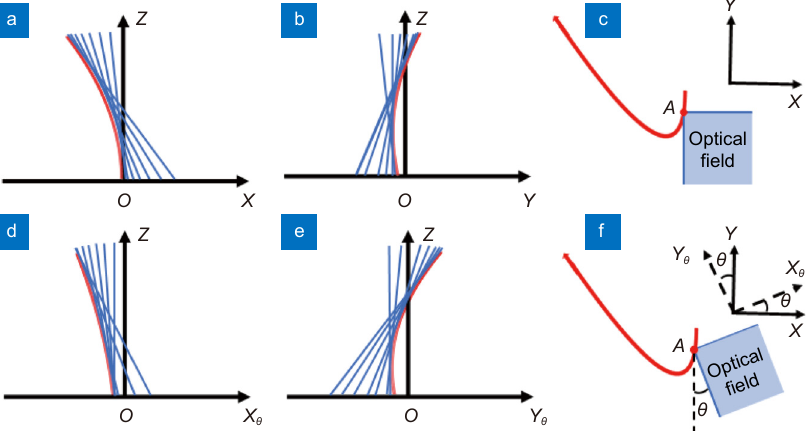
Fig. 1 | Generation of 2D self-accelerating beam based on optical caustic and the rotation principle of transverse optical field for 2D self-accelerating beam. Two perpendicular components ( a )−( b ) of trajectory and light rays in default Cartesian coordinates. ( c ) The projection of multiplexed trajectory and the distribution of transverse optical field in default Cartesian coordinates; two perpendicular components ( d )−( e ) of tra- jectory and light rays in rotated Cartesian coordinates. ( f ) The projection of multiplexed trajectory and the rotated distribution of transverse optical field in rotated Cartesian coordinates.